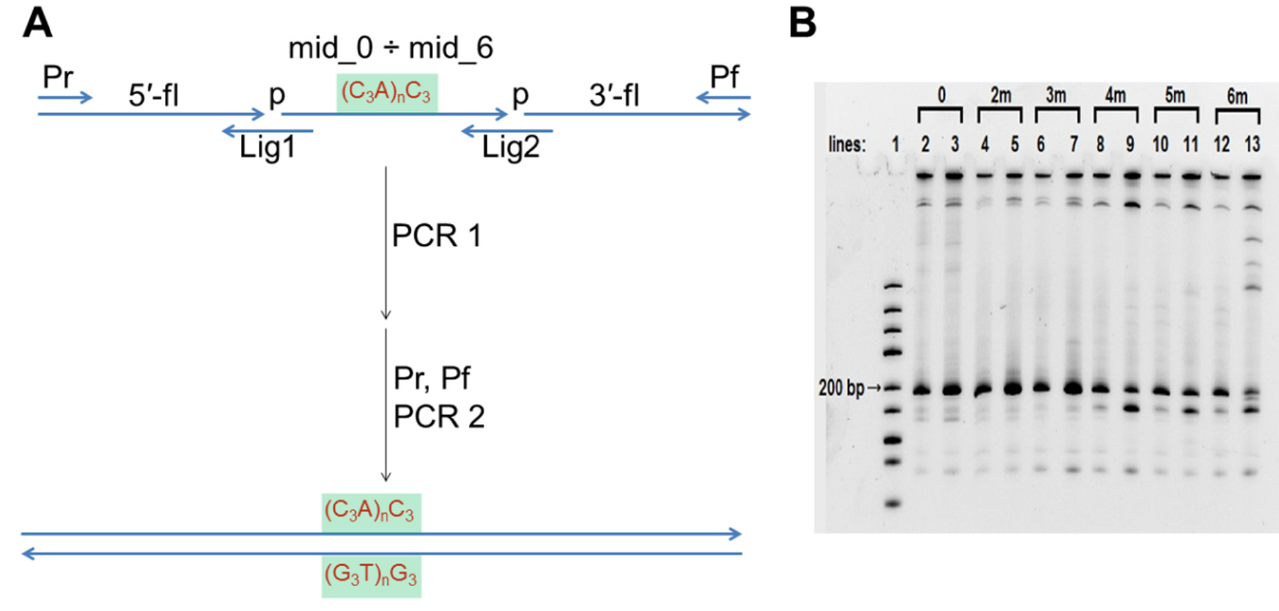
Figure 2. Synthesis of model DNA duplexes 0, 2m, 3m, 4m, 5m, and 6m. ( A ) Scheme of two-step PCR synthesis of model DNA constructs; ( B ) Analytical PAGE of amplification. Line 1–DNA ladder mix, the nearest to desired 195 bp length band (200 bp) is marked. Lines 3, 5, 7, 9, 11 and 13– PCR in the commercial buffer; lines 2, 4, 6, 8, 10 and 12–PCR in the in ‐ house Li ‐ based buffer.